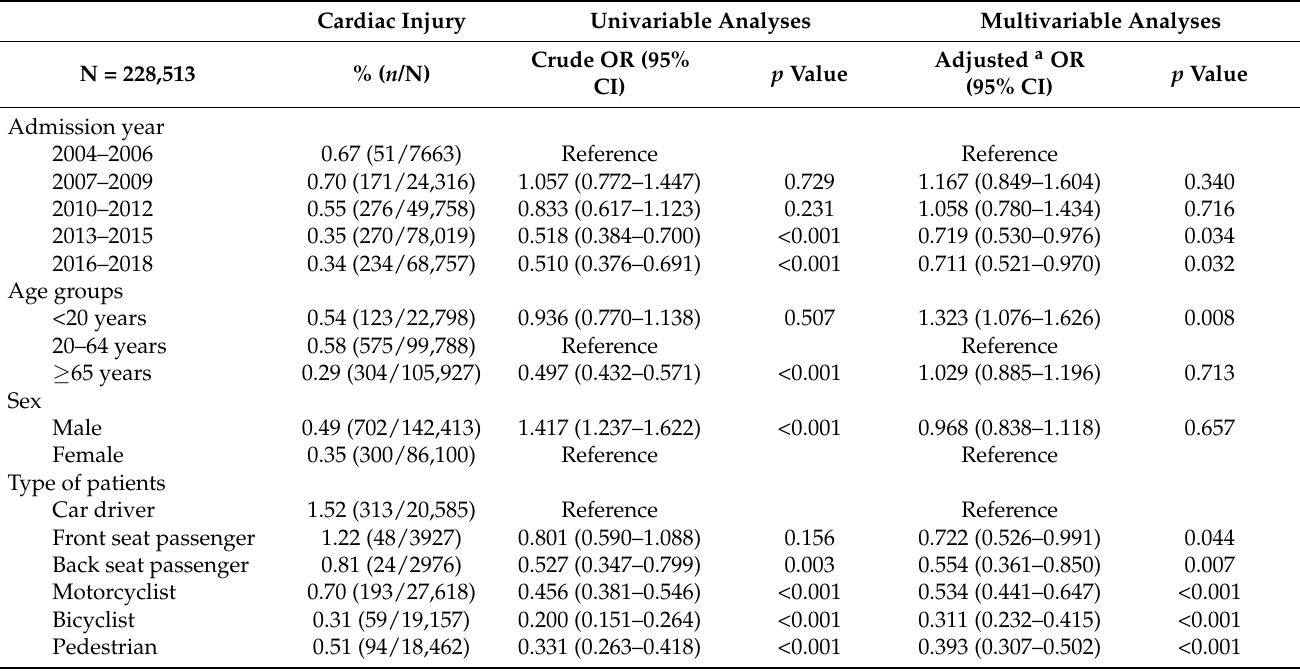
Table 2. Univariable and multivariable logistic regression to identify factors associated with cardiac injury among blunt trauma